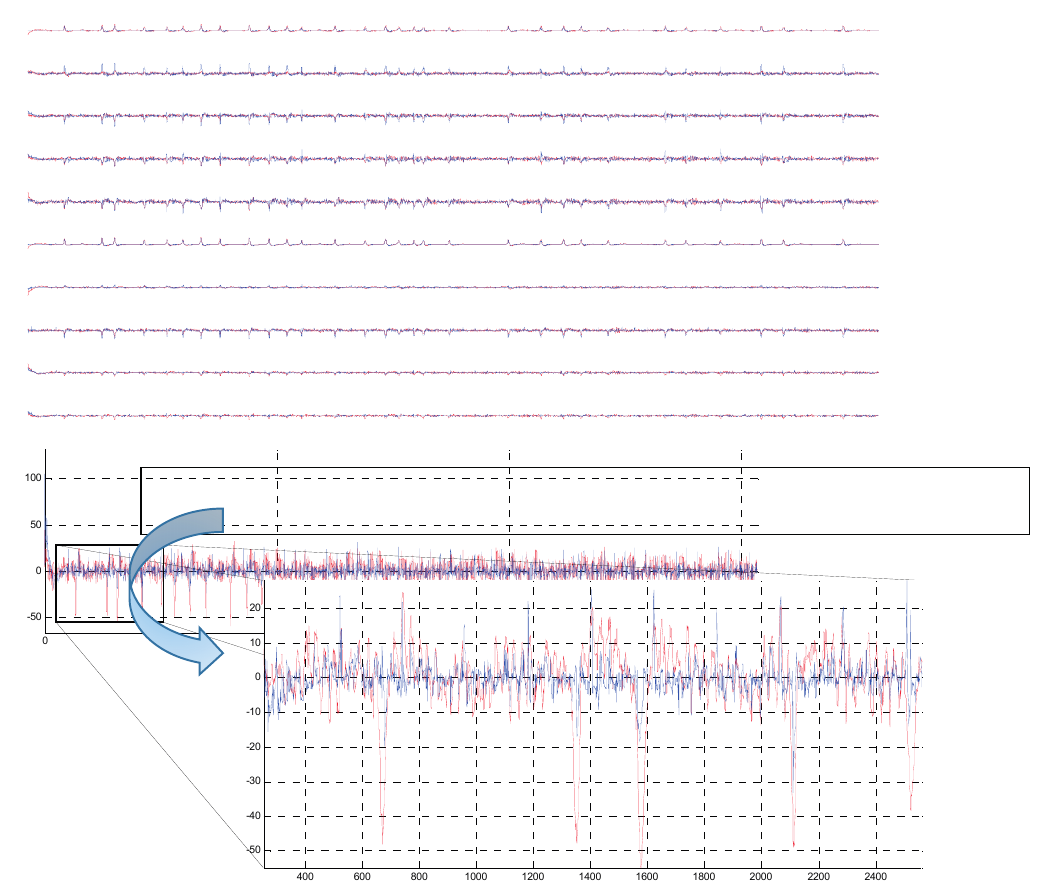
Figure 12. The removal results after the “sym9” MWT were applied on the EEG channels, the EEG signals before artifact removal (in red), the EEG signals after denoising (in blue).